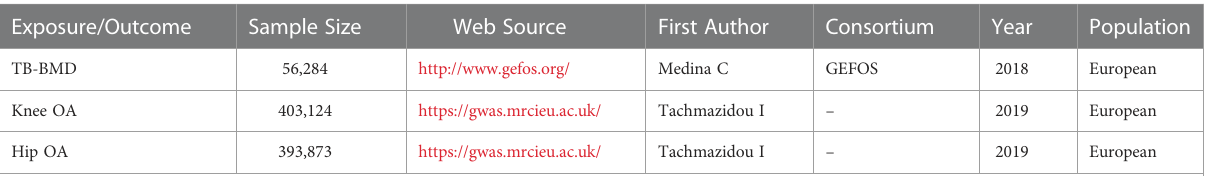
TB-BMD, total body bone mineral density; OA, osteoarthritis; GEFOS, the GEnetic Factors for